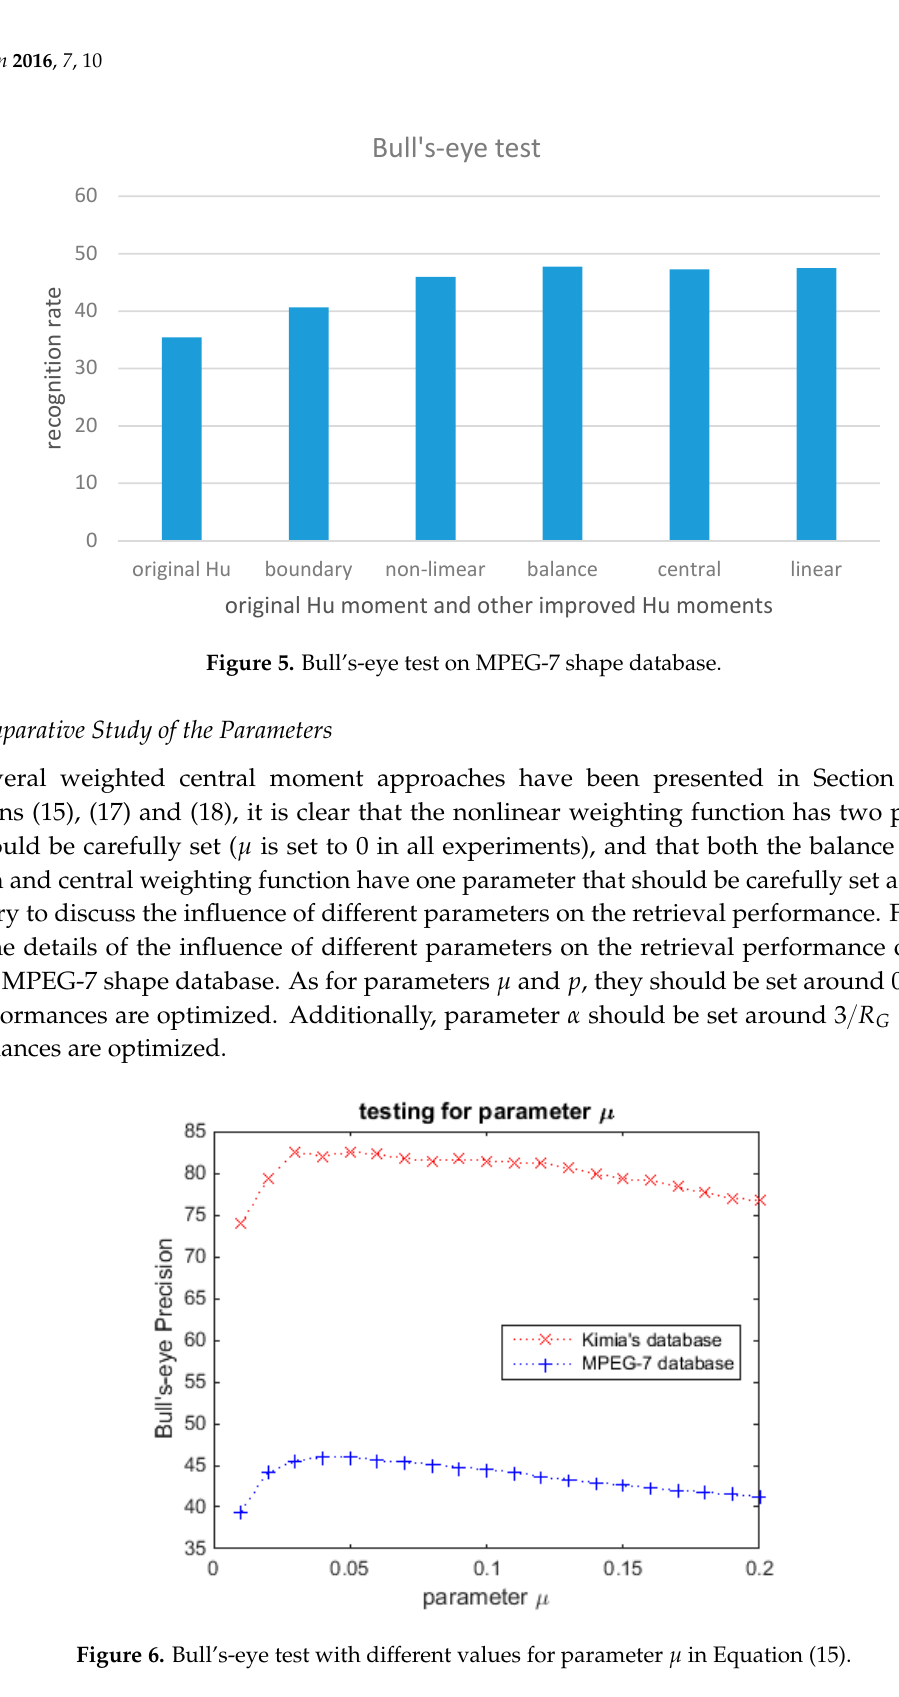
Figure 6. Bull’s-eye test with different values for parameter μ in Equation (15).